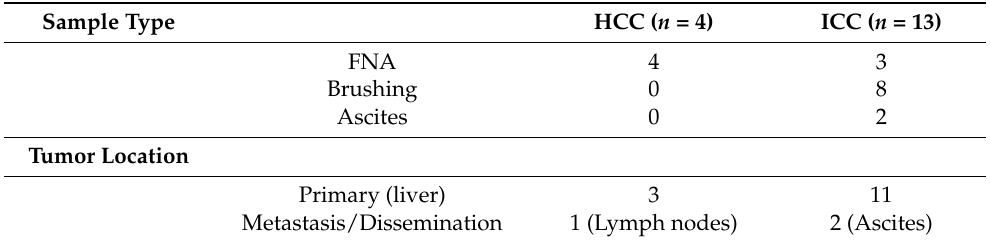
Table 4. Details of Clinical Specimens.